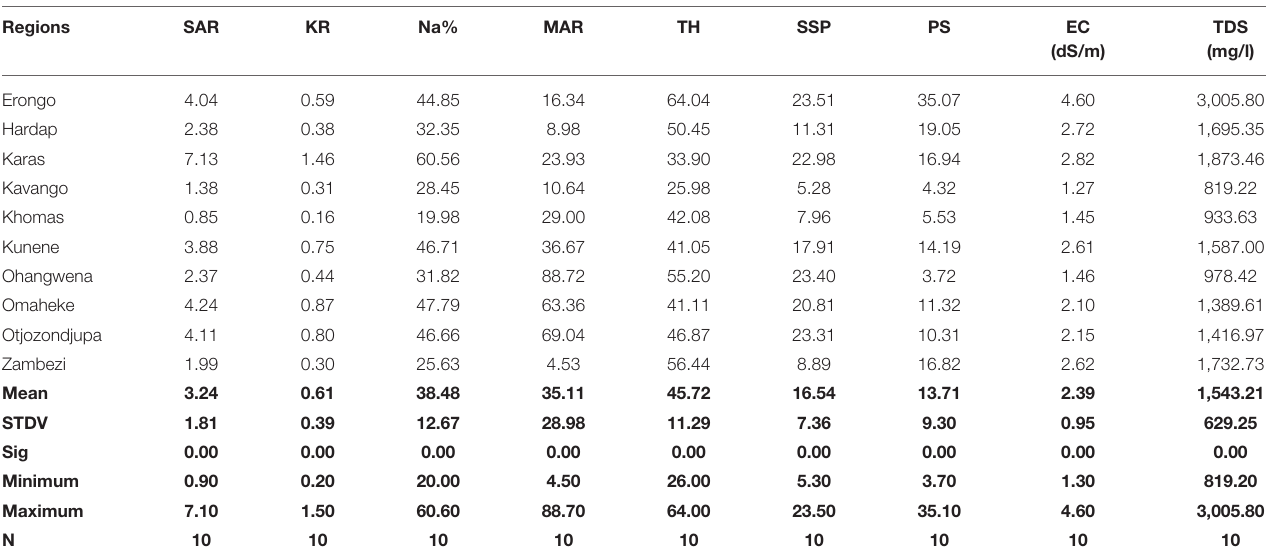
TABLE 9 | Groundwater quality indices for irrigation in 10 regions.